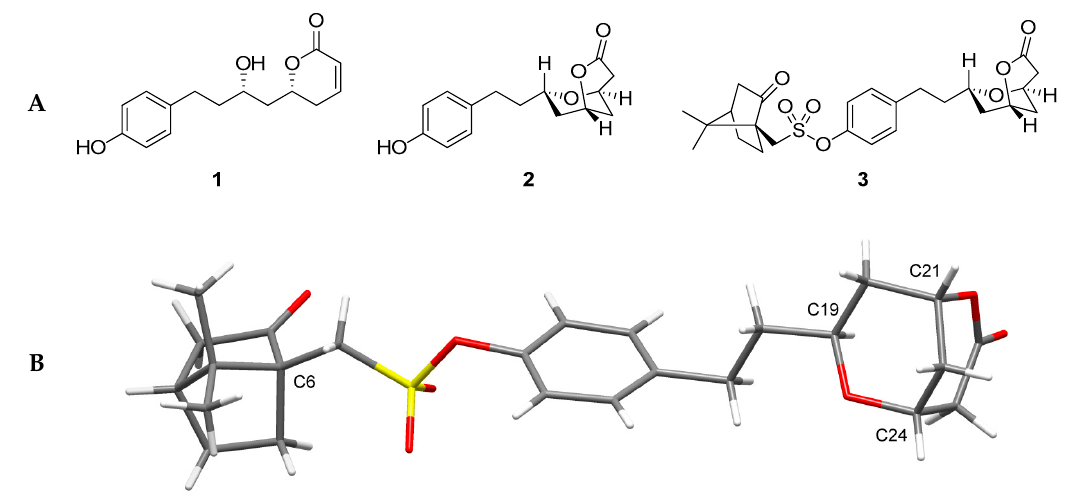
Figure 1. ( A ) Dodoneine 1 and its modification to a bicyclic lactone 2 and its camphorsulfonate analogue 3 ; ( B ) X-ray structure of camphor sulfonate 3 .